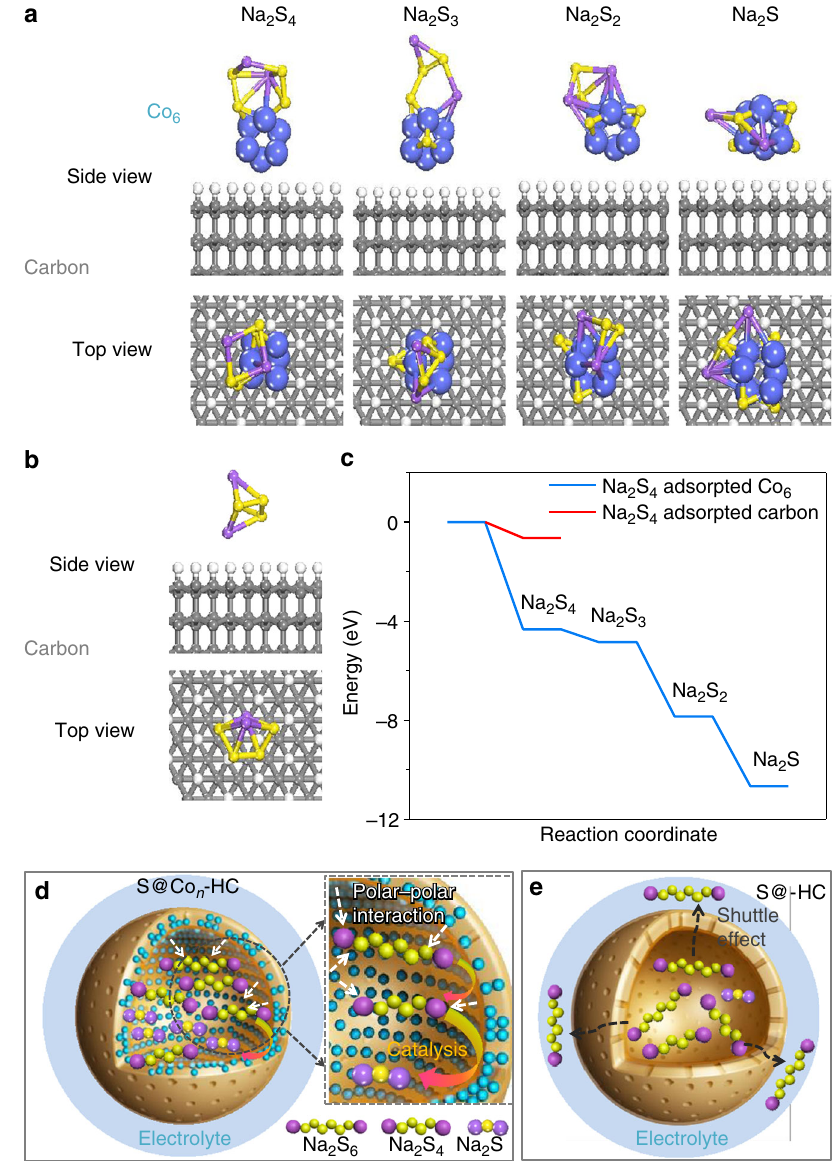
Fig. 6 Density functional theory results and electrode reaction mechanism. a Optimized structures of Na 2 S 4 cluster on carbon-supported Co 6 cluster, and b on carbon support. Purple: Na; yellow: S; blue: Co; gray: C; white: H. c Energy pro fi les of Na 2 S 4 adsorption on carbon-supported Co 6 cluster (in blue) and carbon support (in red). d , e Schematic illustrations of electrode reaction mechanism of atomic cobalt-decorated hollow carbon sulfur host (S@Co n -HC) and hollow carbon hosting sulfur (S@HC),